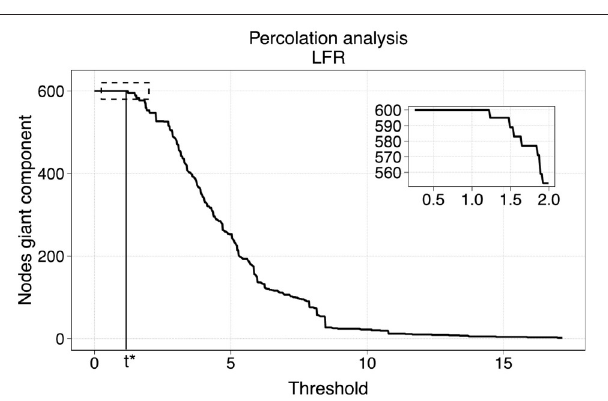
FIGURE 3 | Percolation analysis for a LFR networks. The number of nodes in the giant component has a step-wise behavior with respect to the threshold. The percolation threshold value is